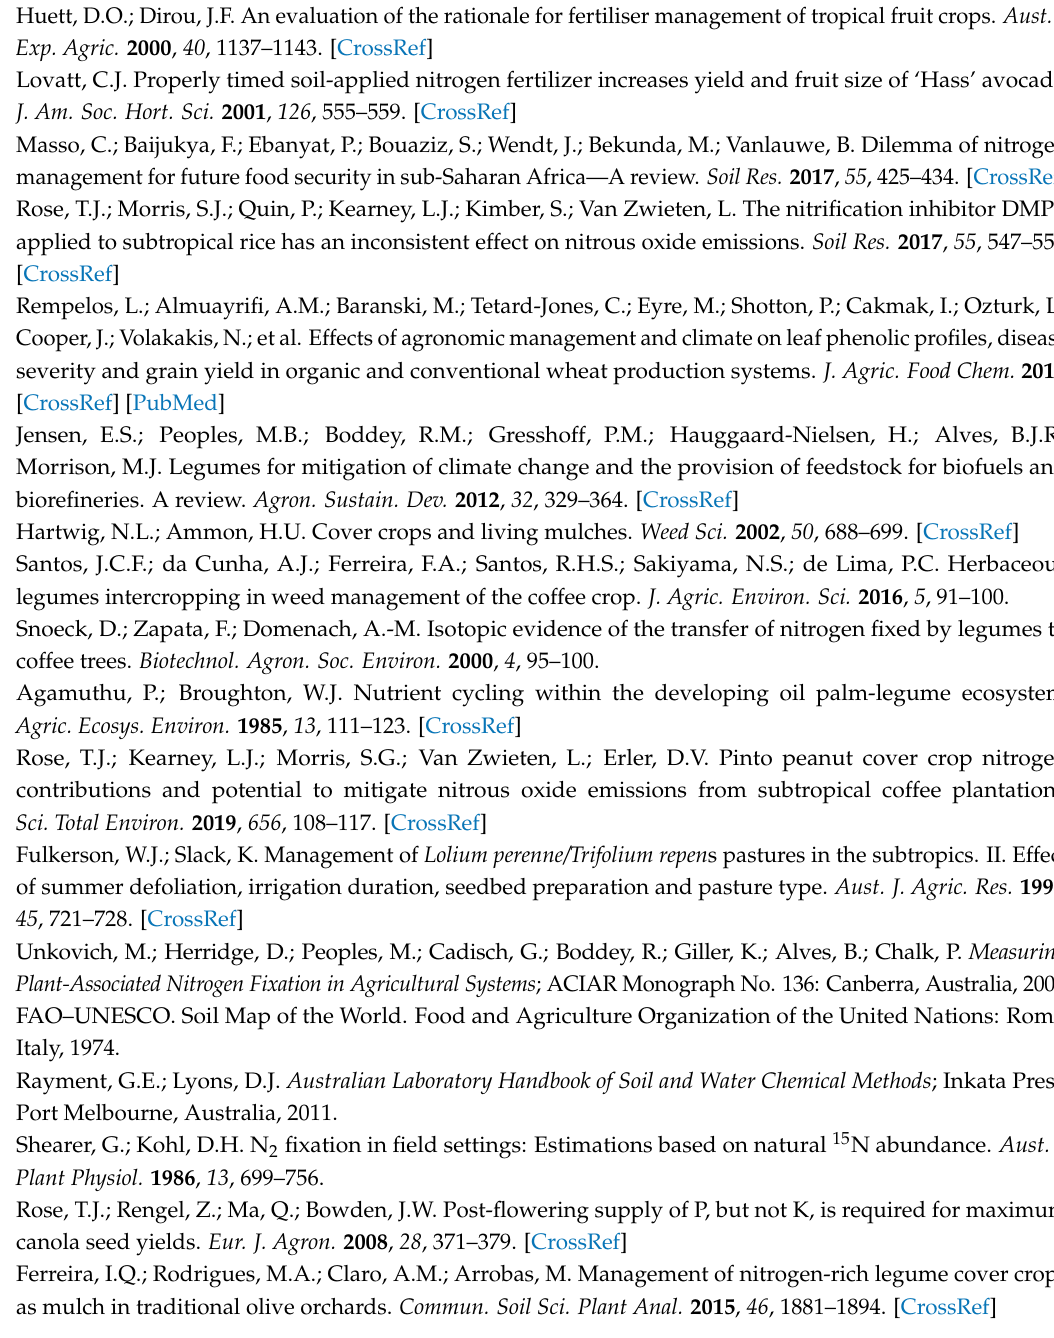
Figure S1: Rainfall and daily maximum temperature data for the experimental period at (a) the Tuckombil site and (b) the Alstonville site, Table S1: Nutrient concentration in whole shoots of white clover at flowering at the Alstonville